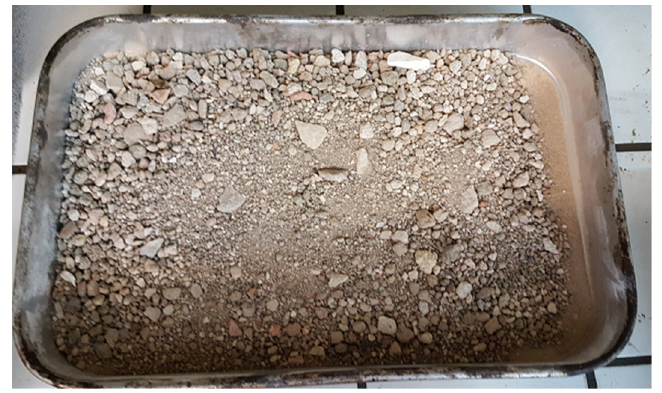
Figure 2. Dried construction and demolition recycled aggregates.